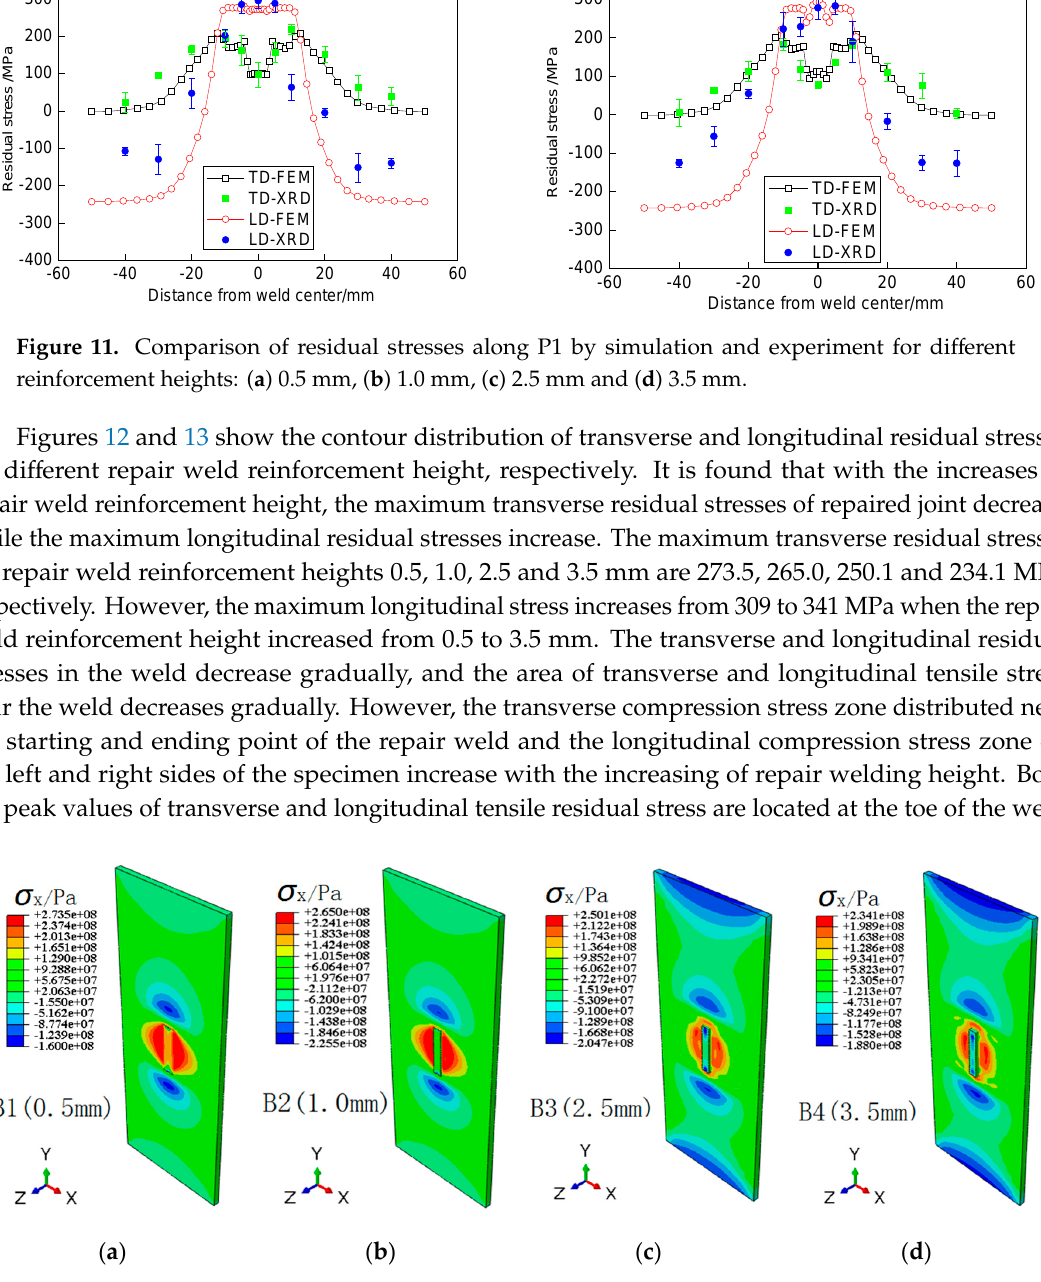
Figure 12. Contours of transverse residual stress for different repair weld reinforcement heights: ( a ) 0.5 mm, ( b ) 1.0 mm, ( c ) 2.5 mm and ( d ) 3.5 mm.